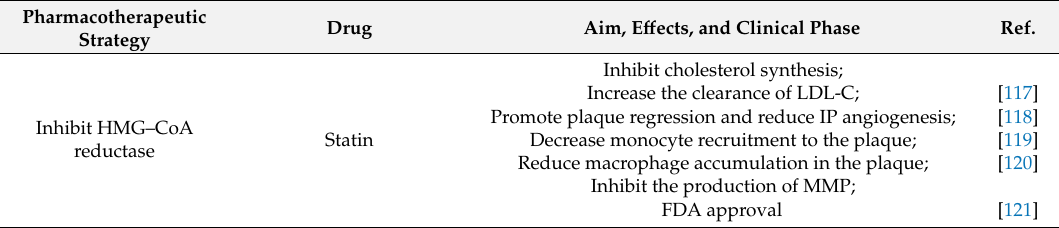
Table 2. Therapeutic options in vulnerable plaque. Summary of strategies to stabilize or regress vulnerable